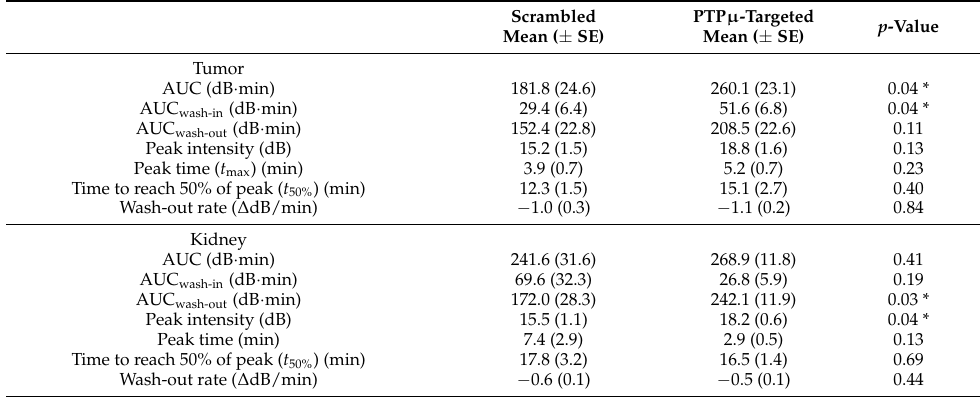
Table 1. Summary of parameters extracted from time intensity curves for tumor and kidney.